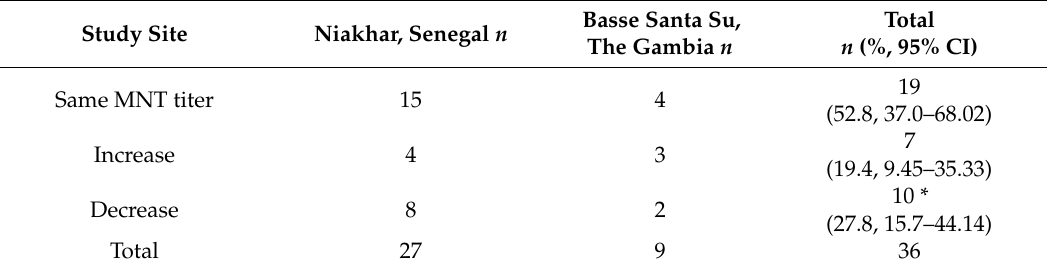
Table 4. Anti-ZIKV MNT immunity over time in samples collected in Senegal and The Gambia, by MNT titer dynamics. The MNT titer range considered was 1:40–1:640 serum dilution. * included 6 samples from Senegal found negative in 2011 /